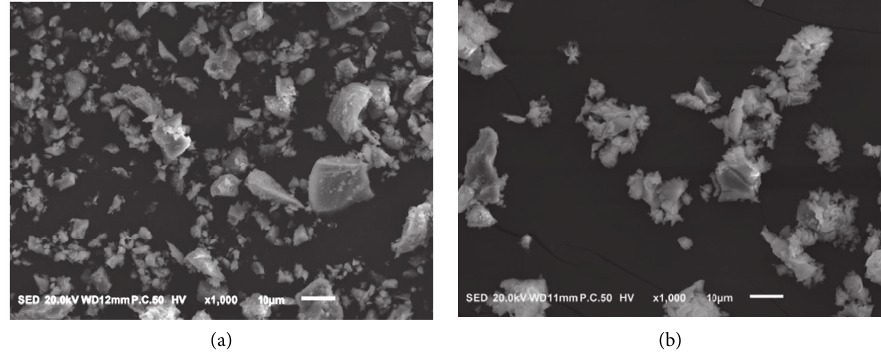
Figure 4: SEM micrographs of static blasting materials before and after hydration reaction: (a) before reaction; (b) after 24 hours of